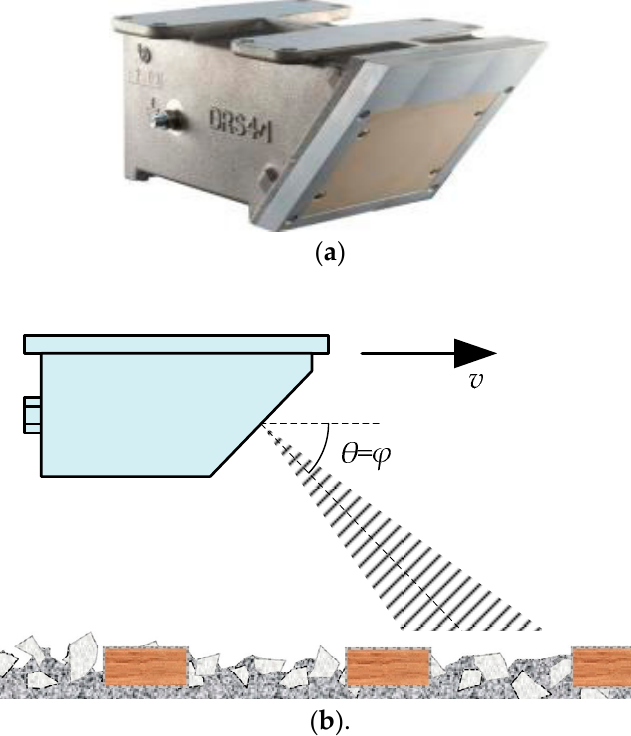
Figure 2. Train-borne single-channel DRS: ( a ) Appearance view of DRS4; ( b ) Schematic diagram of working principle.